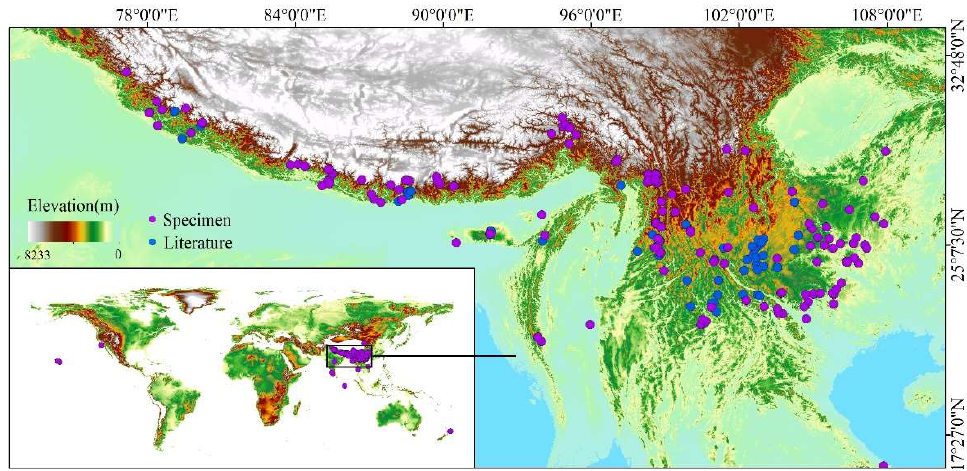
Figure 2. Geographic distribution of Nepalese alder based on information from specimen and liter-